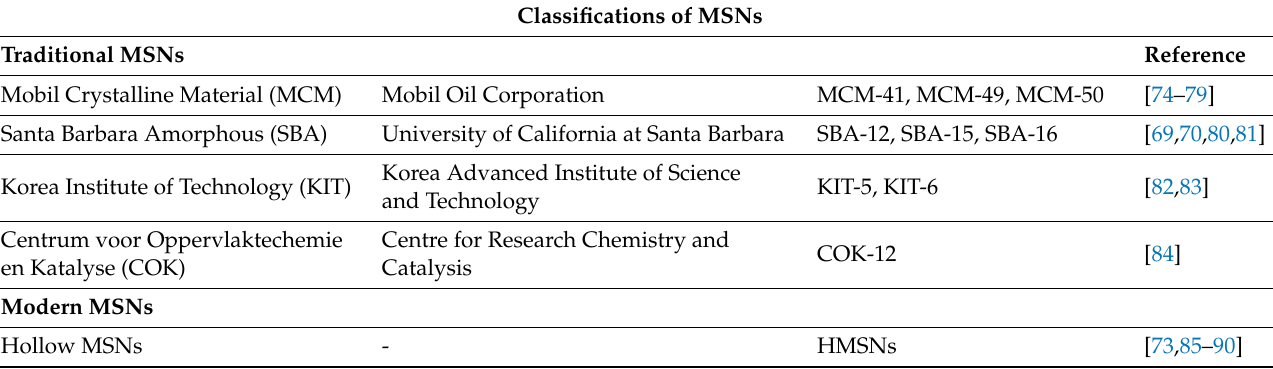
Table 2. Classification of material-based traditional MSNs and modern hollow